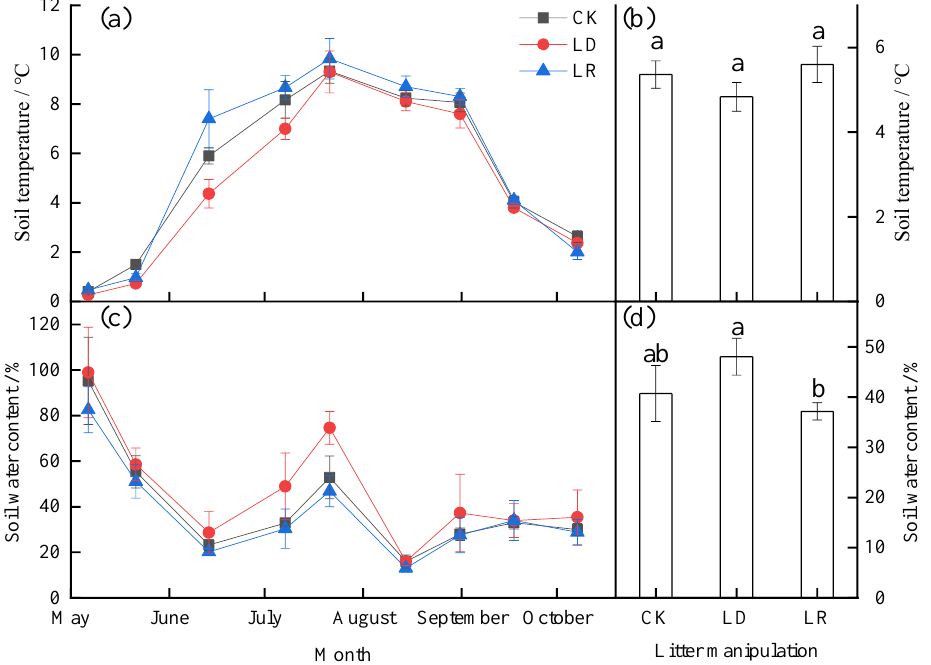
Figure 2. Monthly dynamics of the soil temperature ( a ) and soil water content ( c ) and their averages ( b , d ) under different litter manipulation treatments during the study period. The subplots with three bars show the average soil temperature and soil water content for the entire study period ( n = 3). The different lowercase letters above the bars indicate significant differences among different litter manipulation treatments ( n = 27); values are the mean ± SD. Litter manipulation treatment abbreviations: CK, unchanged litter input; LD, doubled litter; LR, litter